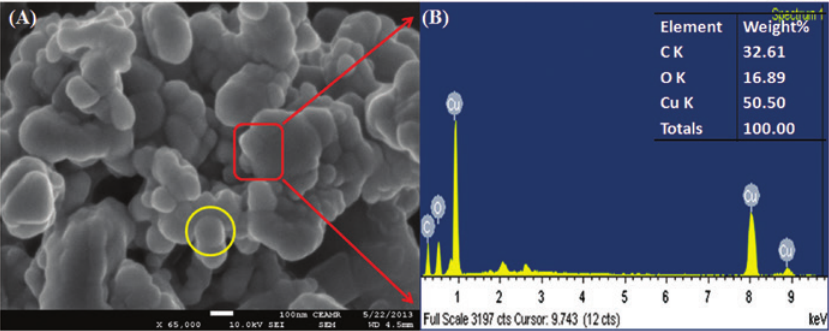
Figure 4: (A) High-resolution FE-SEM image and (B) EDX investigation of prepared CuNPs.